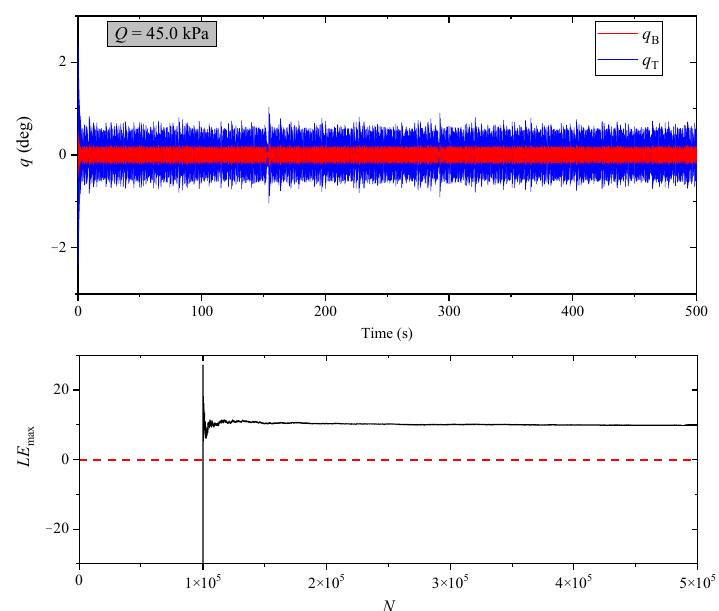
Figure 17. Variation of Poincaré sections with dynamic pressure at different δ B / δ T values. The sampling interval is 1.0 kPa.